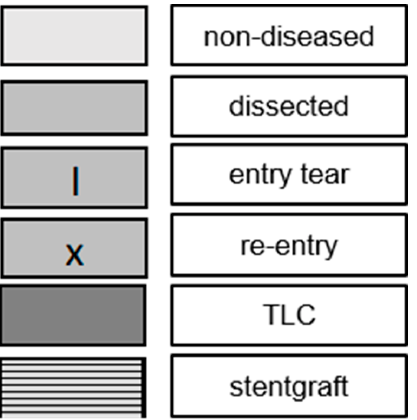
Figure 4. Explanatory caption of Figure 3A–C as well as Figure 5.